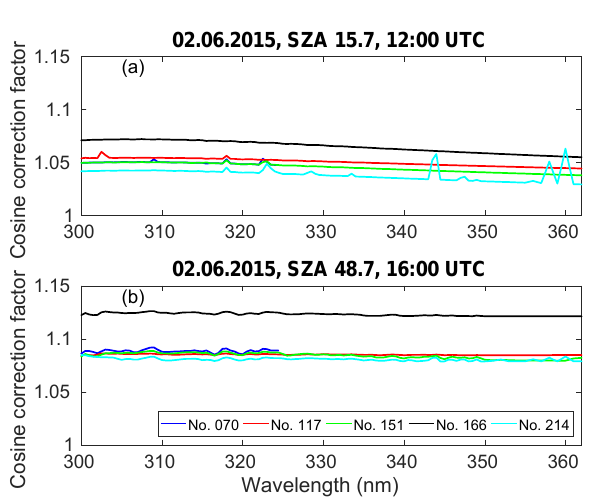
Figure 5. Spectral variation of the cosine error correction factor of Brewers no. 070, no. 117, no. 151, no. 166 and no. 214 during one UV scan at (a) 12:00UTC (SZA 16 ◦ ) and (b) 16:00UTC (SZA 49 ◦ ) on 2 June